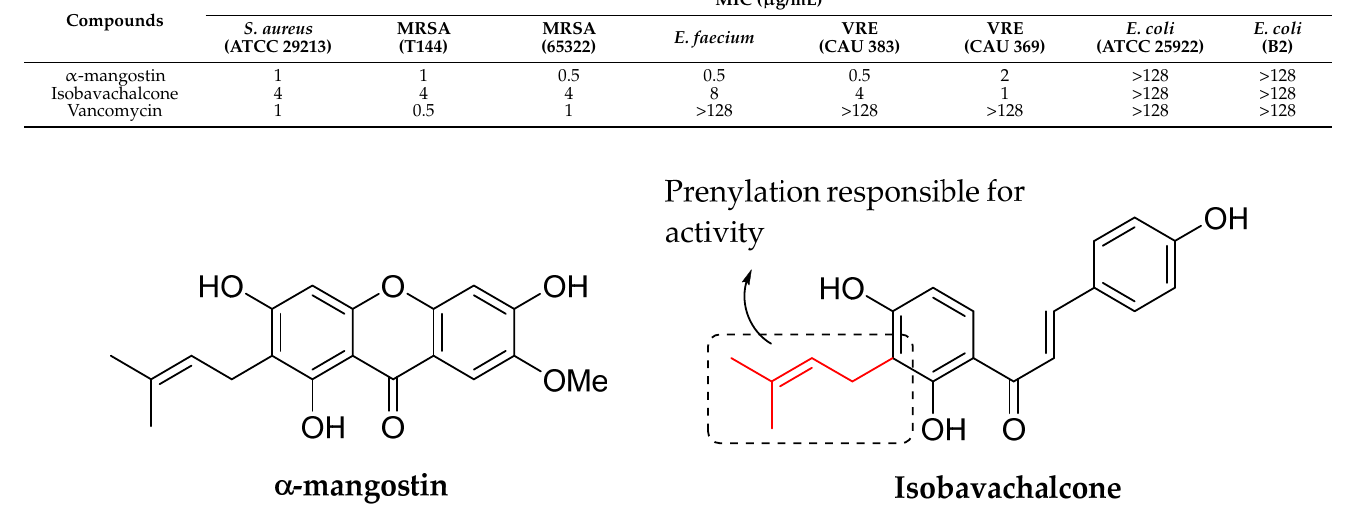
Figure 21. α -mangostin, isobavachalcone and structural feature responsible for antibacterial activity [65].